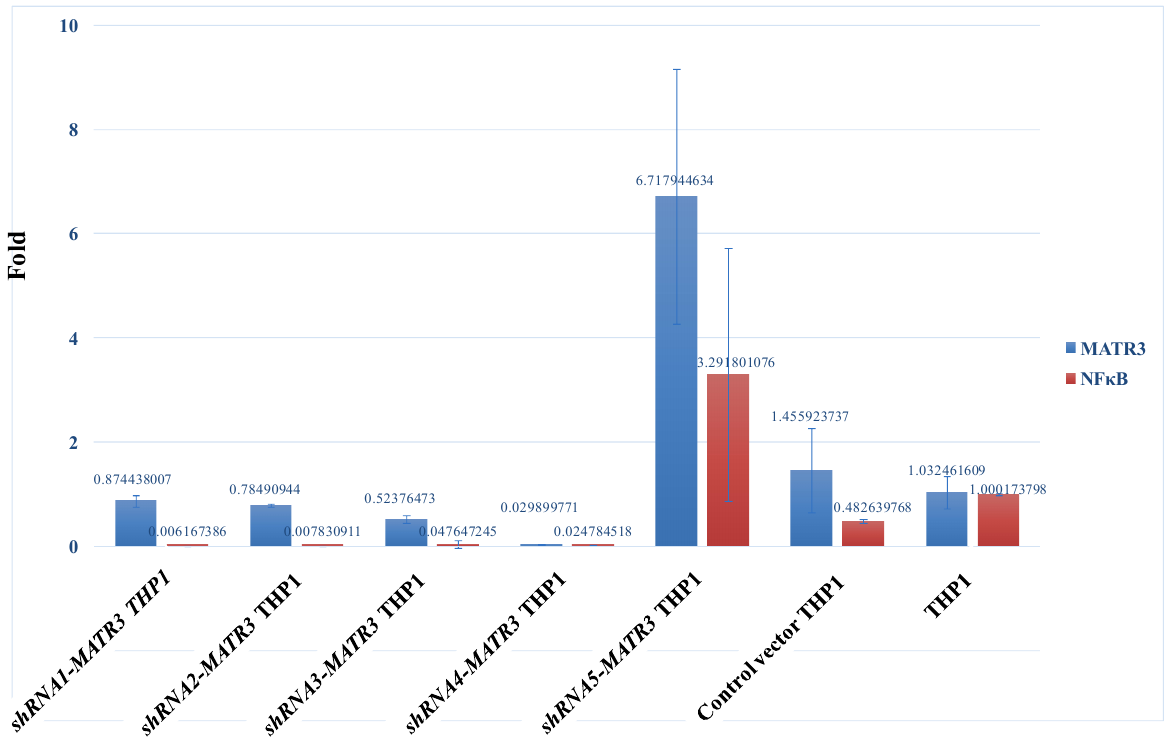
Figure 3. Five shRNA- MATR3 lentivirus particles were used to knock down MATR3 in THP1 cells. shRNA4-MATR3 KD THP1 cells showed the lowest MATR3 mRNA expression, followed by shRNA3- and shRNA2- MATR3 KD THP1 cells. There is no correlation between MATR3 and NFκB mRNA expression in MATR3 -KD THP1 cells. We used 0.1 µL and 0.5 µL carboxylate modified polystyrene latex beads, with red fluorescent, as a phagocytosis stimulator to evaluate the phagocytotic ability of shRNA- MATR3 -KD THP1 cells. Co-culture of s hRNA-MATR3 -KD THP1 cells with 0.5 µL latex beads and THP1 cells for 3 h showed better phagocytic effects. More latex beads were phagocytosed by shRNA2-MATR3 -KD and shRNA4-MATR3 -KD THP1 cells, compared to that by the control vector and naïve THP1 cells, based on flow cytometry and fluorescent microscope analysis (Figure 4, Supplementary Figures S1 and S2).